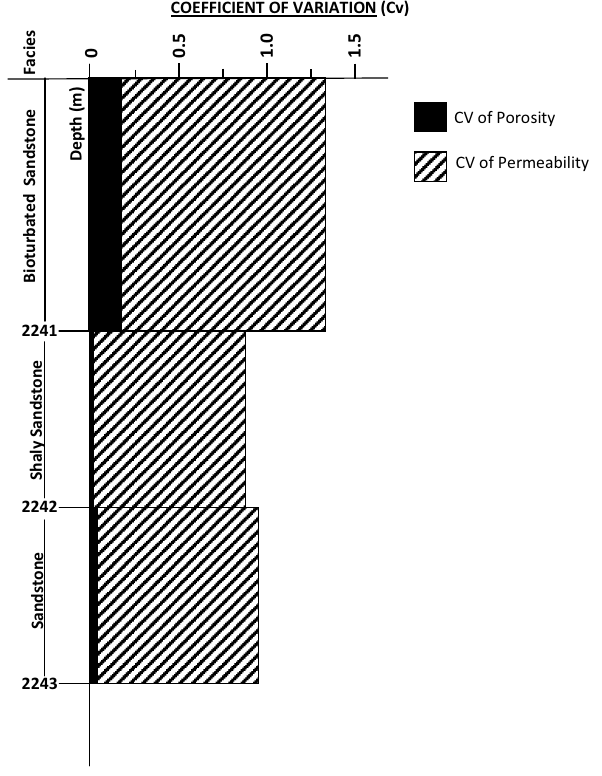
Fig. 6 Facies derived log showing changes of coefficient of porosity and permeability variation in PZ-4